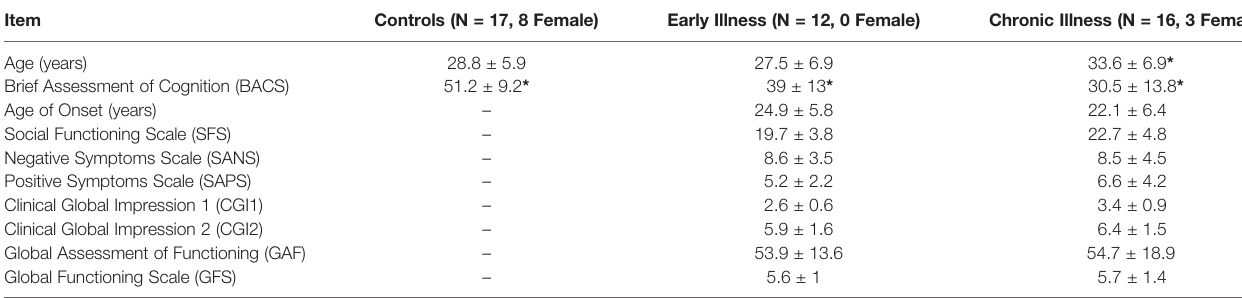
TABLE 1 | Demographic and clinical